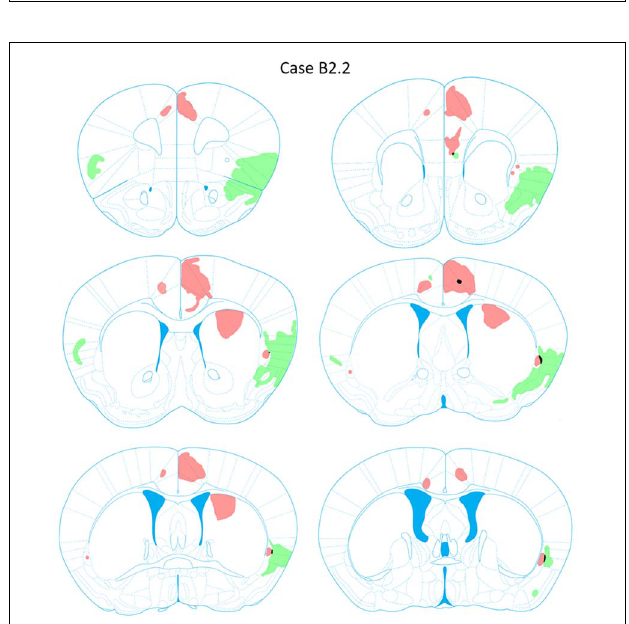
FIGURE 8 | Chartings of anterograde labeling following viral injections into the aINS (green) and ACC (red) (case B2.2). Overlap in expression is colored in